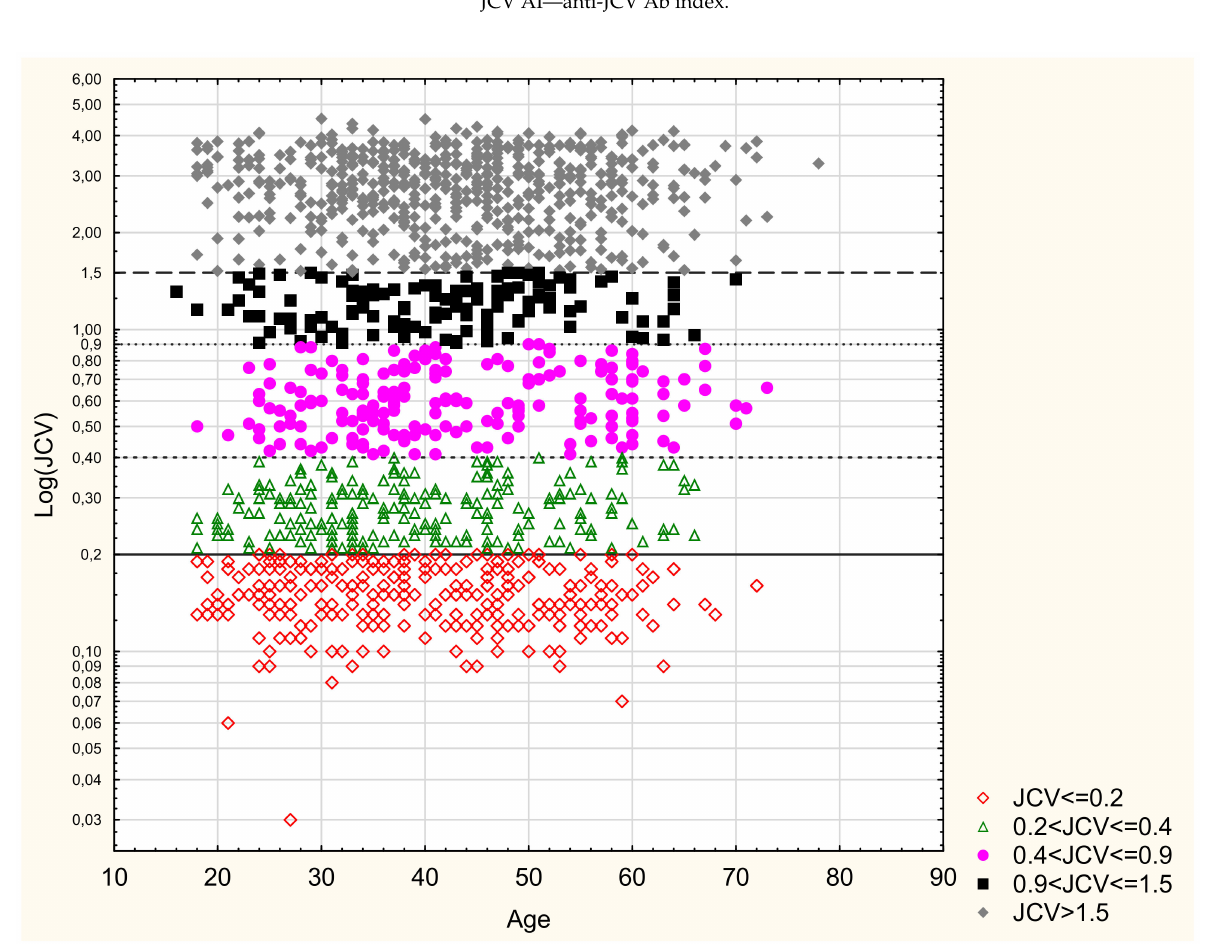
Figure 2. Anti-JCV AI categories and